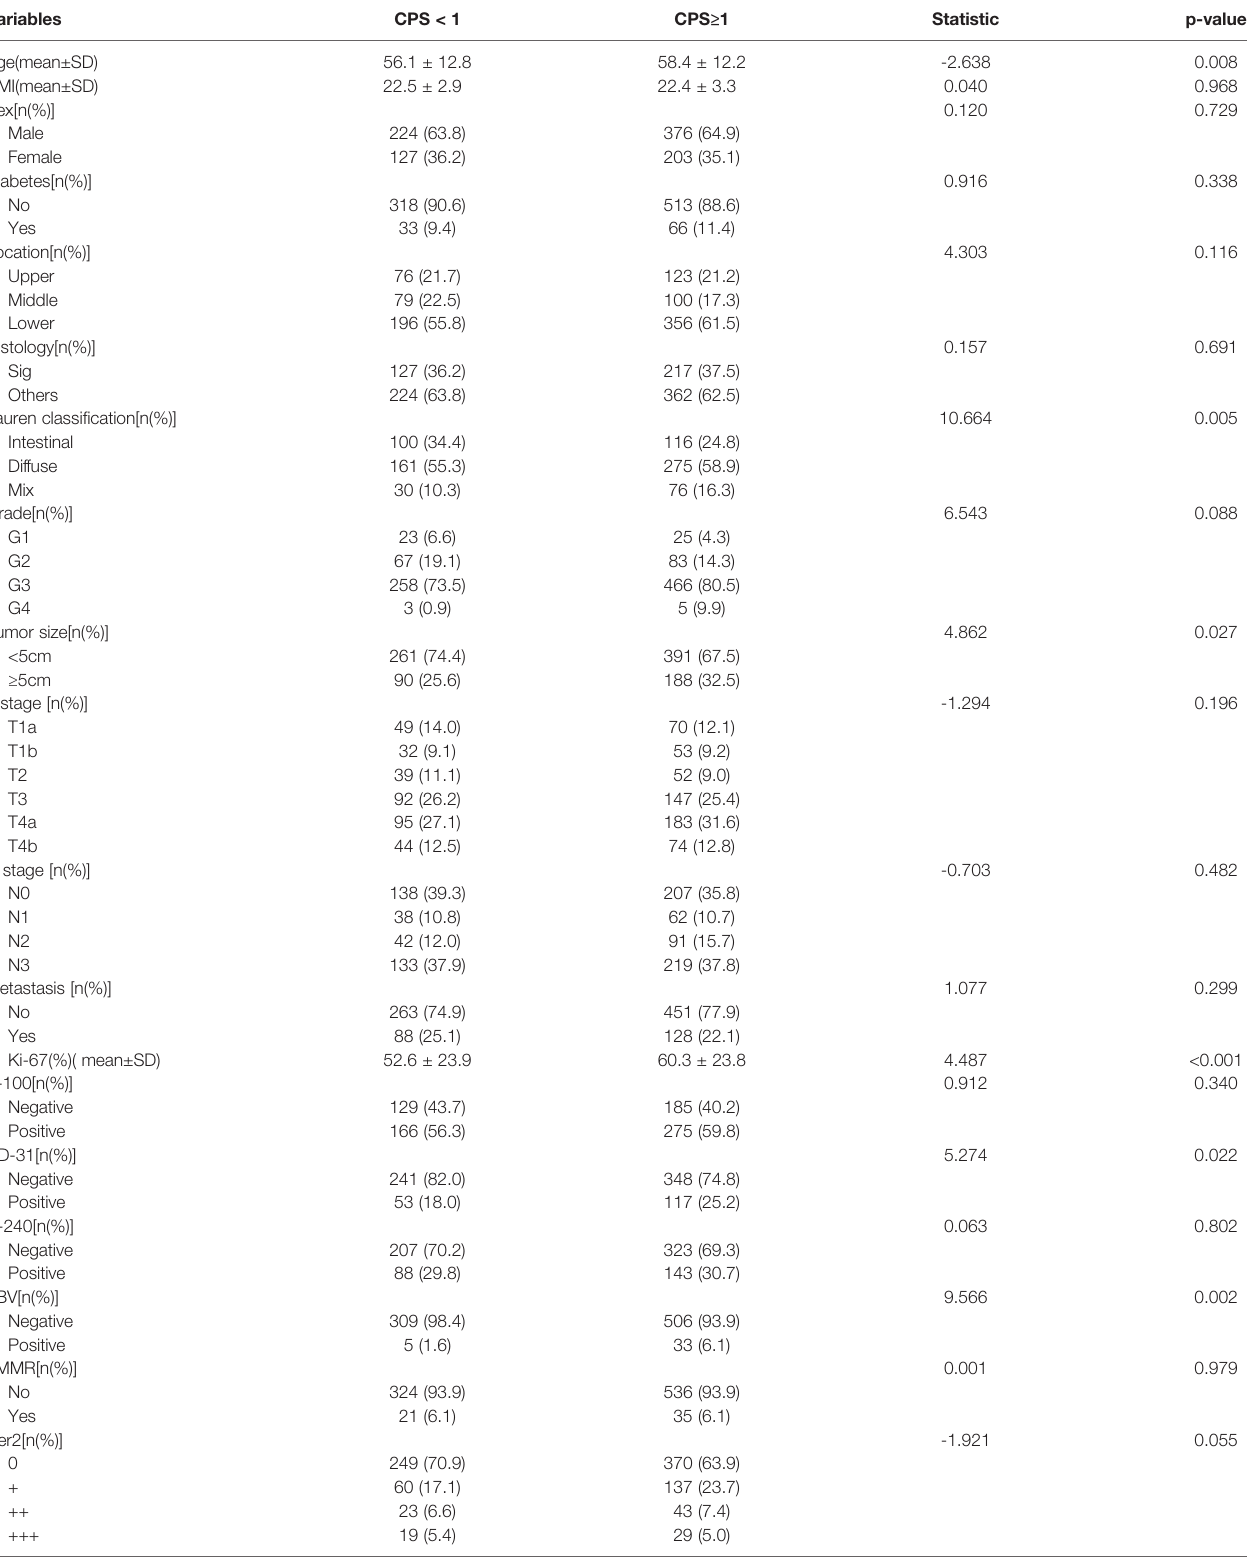
TABLE 3 | Clinicopathological features associated with PD-L1 expression of CPS ≥